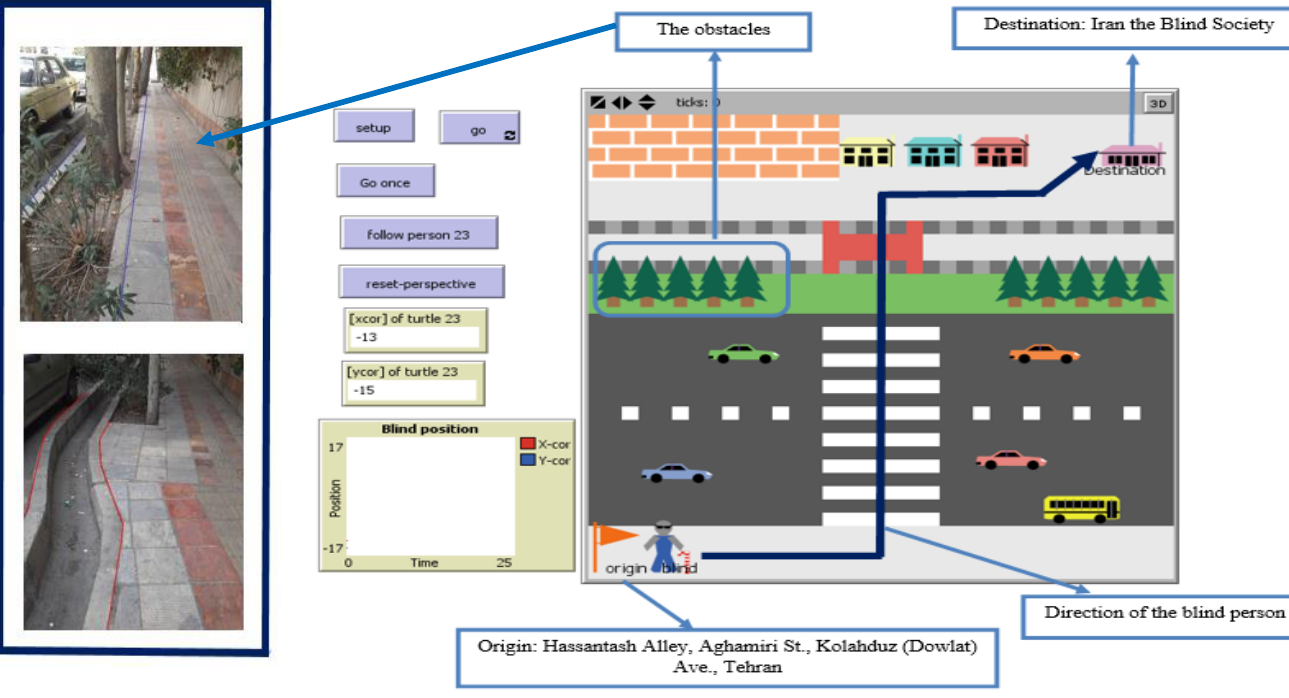
Figure 5. Simulation of the designed